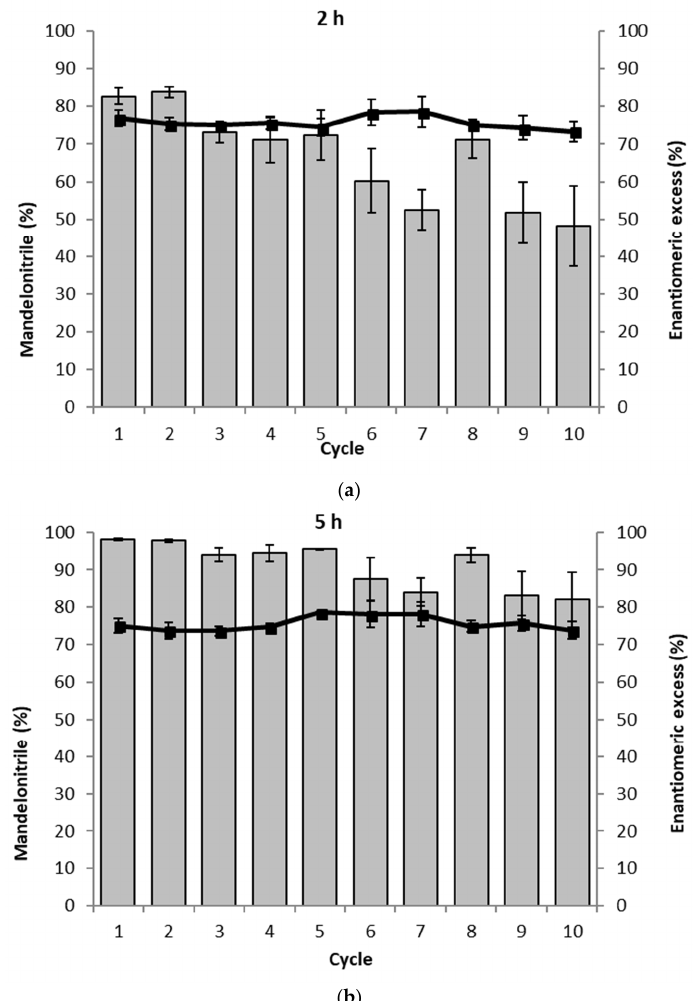
Figure 5. The recycling of the loosely packed Pa HNL immobilized on Celite in ten successive mandelonitrile synthesis reactions. The assay was performed in duplo and the average of both results is shown. The gray bars represent the conversion to mandelonitrile (%) and ■ and the solid line represent the enantiomeric excess (%). Conditions: benzaldehyde (±106 mg, 1 mmol), 2 mL ∙ HCN solution in MTBE (1.5 M), 1,3,5 ‐ triisopropylbenzene (±25 mg, internal standard) and a small, loosely packed teabag filled with the Pa HNL immobilized on Celite R ‐ 633 (6.5 U/mg; 50 mg), stirred at 900 rpm at room temperature. ( a ) Results after 2 h; ( b ) Results after 5 h.